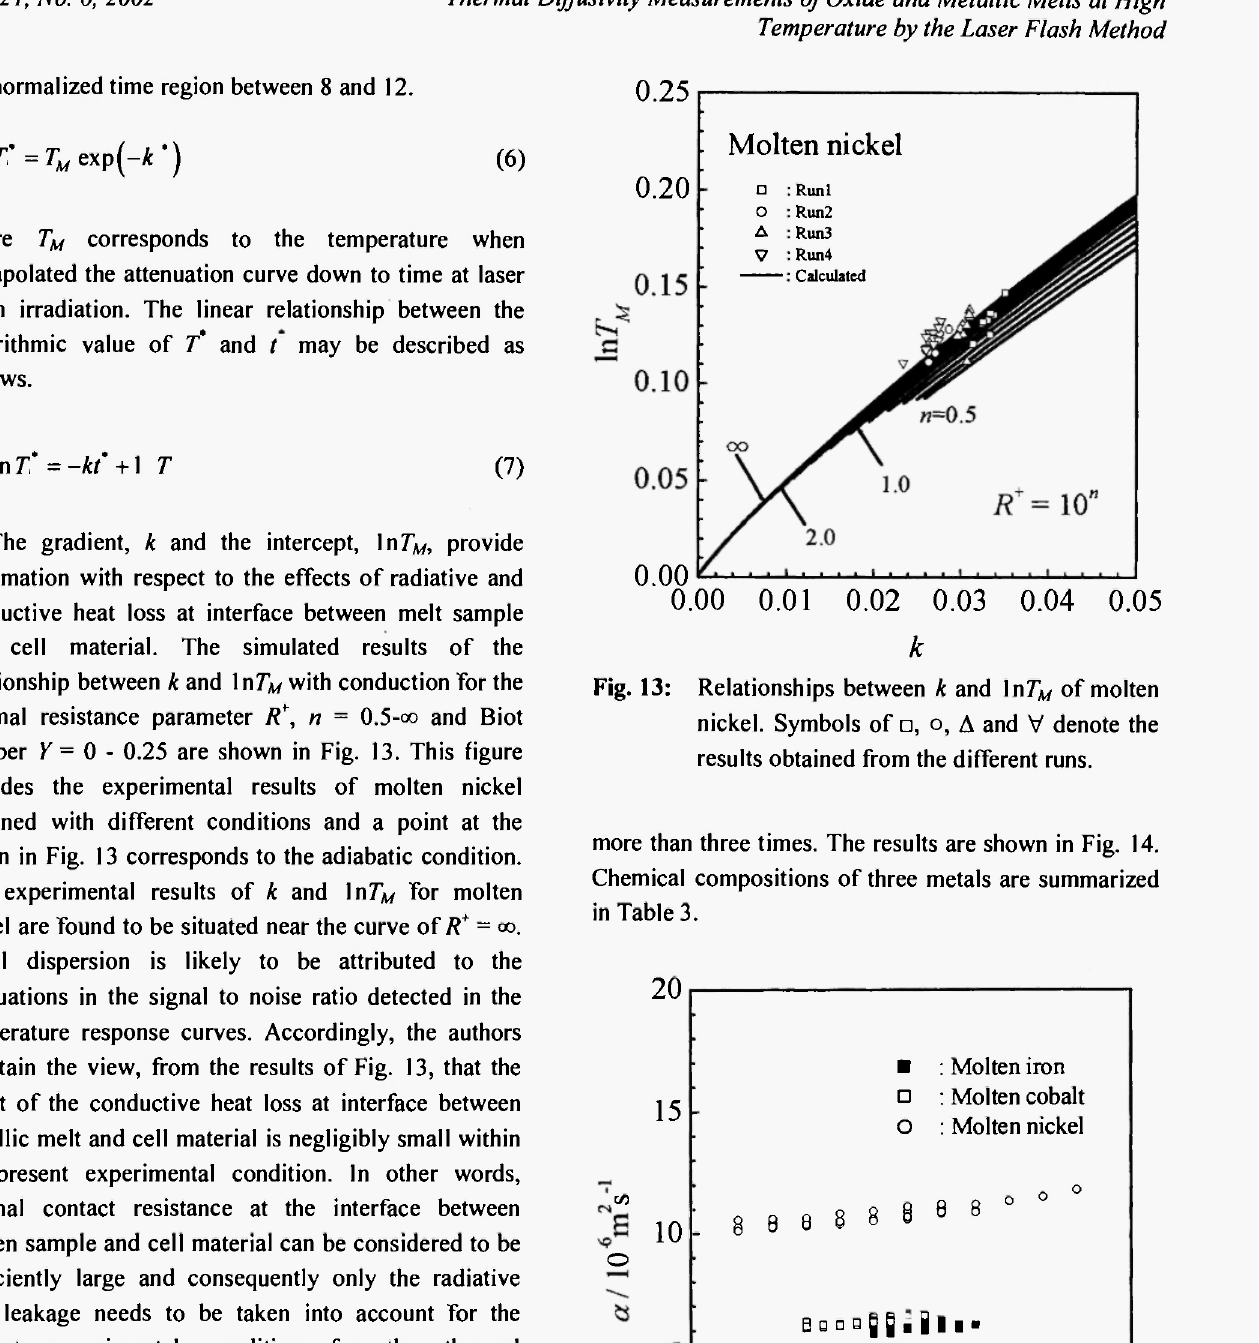
more than three times. The results are shown in Fig. 14.